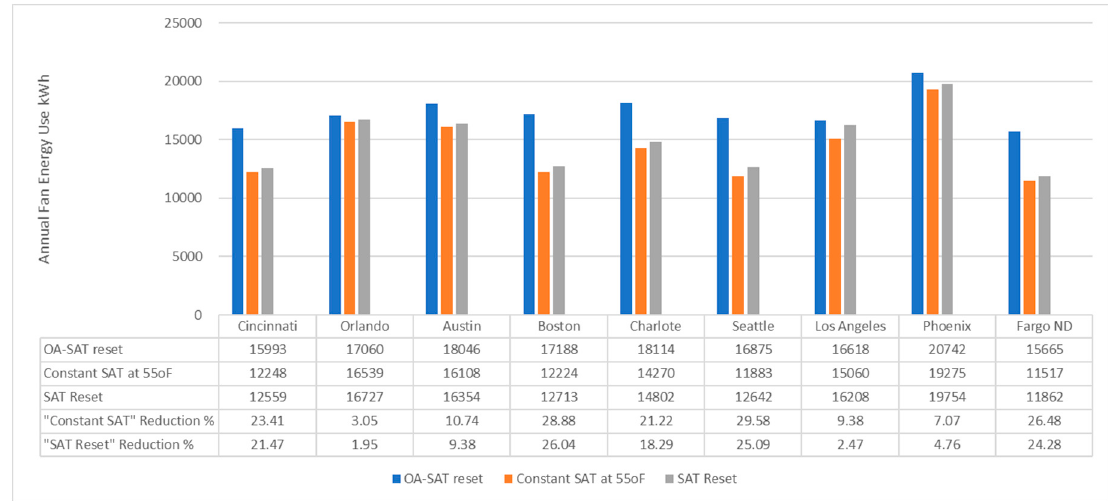
Figure 12. Annual fan energy for dual VAV systems using different SAT reset strategies.